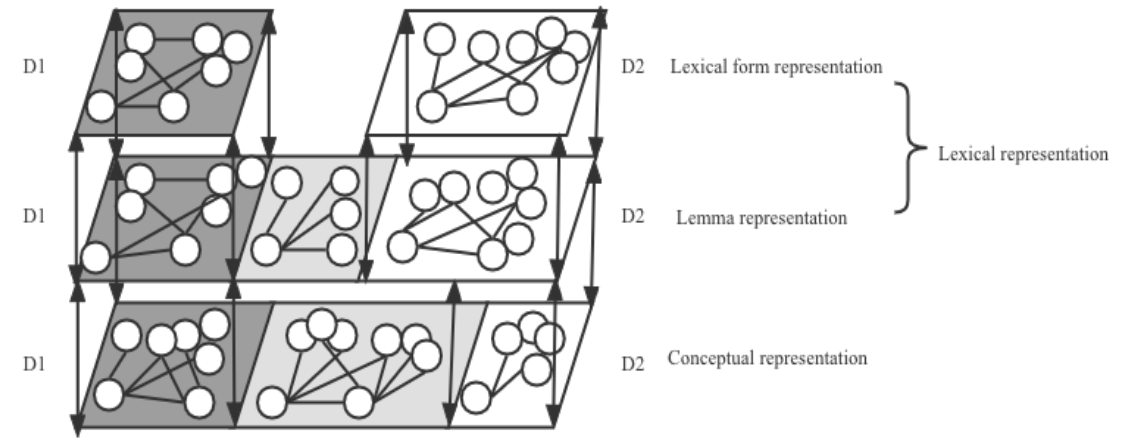
Figure 6. Dialect bilingual two-layer activation model.